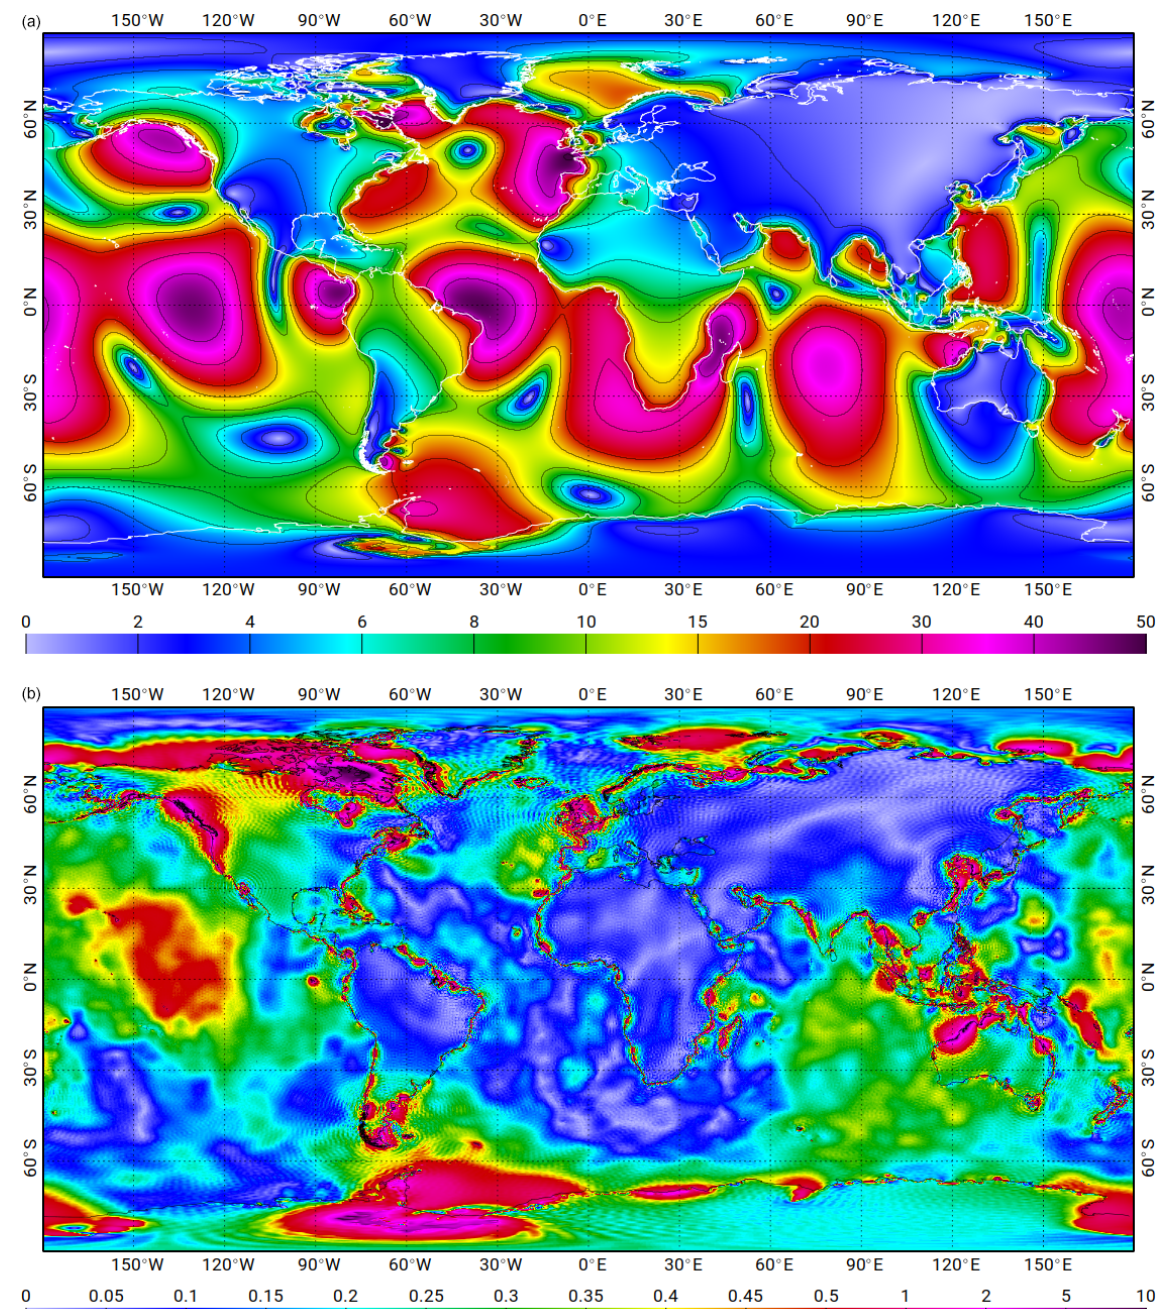
Figure 21. (a) M2 tidal loading, vertical displacement (cm); (b) M2 tidal loading vector difference between FES2014b and GOT4.10 (cm). Wave-like patterns visible in some regions are likely due to differences between Green’s function-based computation of LSA (as in FES2014- derived atlas) and spherical-harmonics-based computation